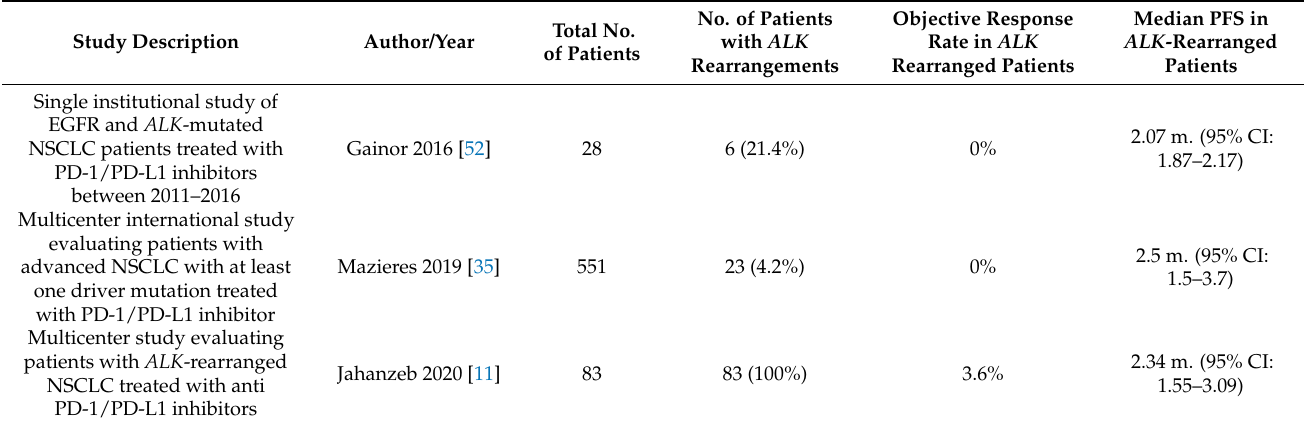
Table 1. Retrospective studies evaluating patients with advanced ALK -rearranged non-small cell lung cancer treated with immune checkpoint